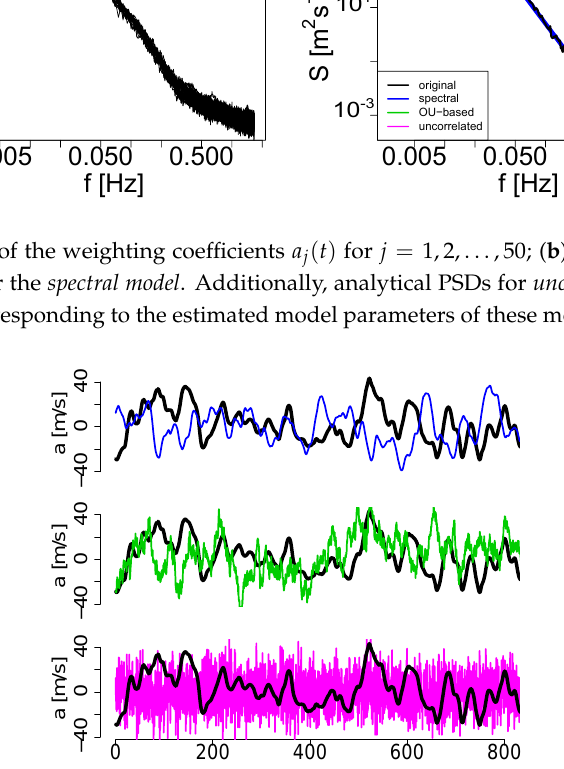
Figure 14. Time series of a 2 ( t ) (black) and the different stochastic models ˜ a 2 ( t ) . From top to bottom: spectral model (blue), OU-based model (green) and uncorrelated model (magenta).